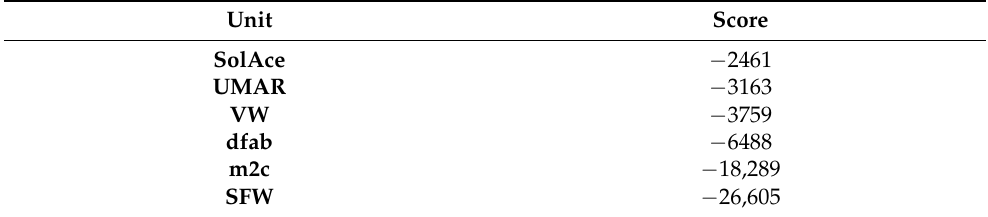
Table 6. Ranking of the units based on the rewarding score, in the analysis period (October 2018– October